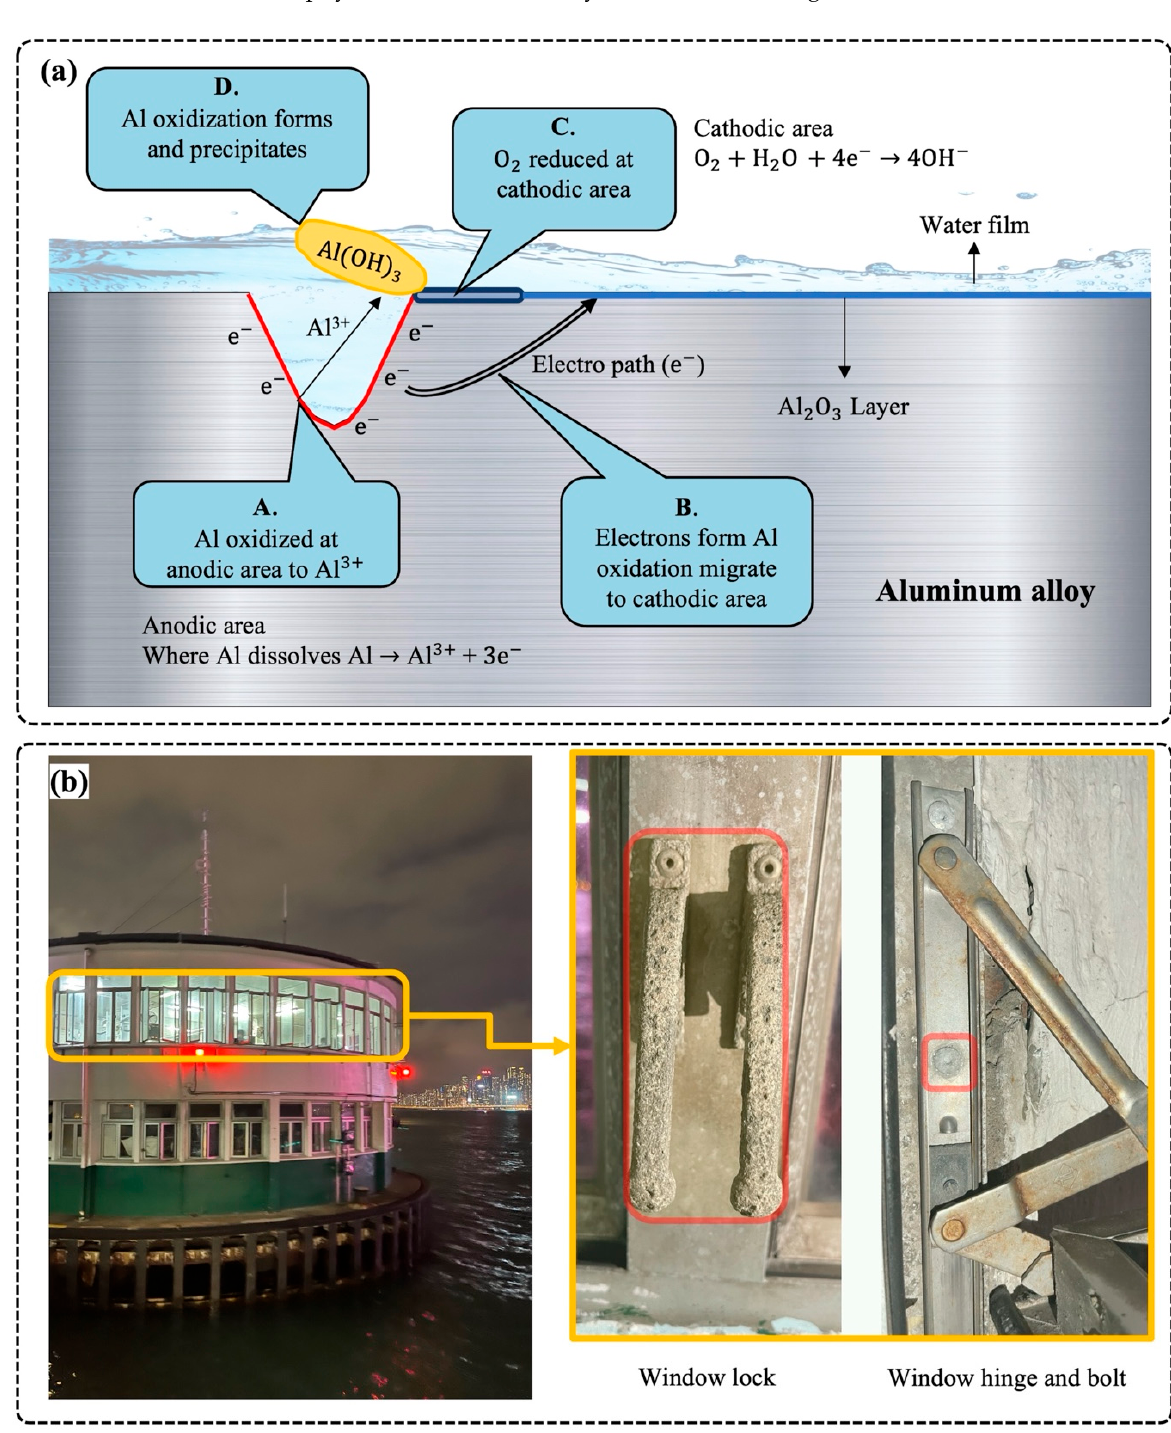
Figure 1. The effect of moisture and chloride ions on aluminum window. ( a ) Schematic illustrations for electrochemical reactions at the aluminum interface. ( b ) The connection components, namely the lock, hinge, and bolt of the aluminum window, corrode in salt environments.